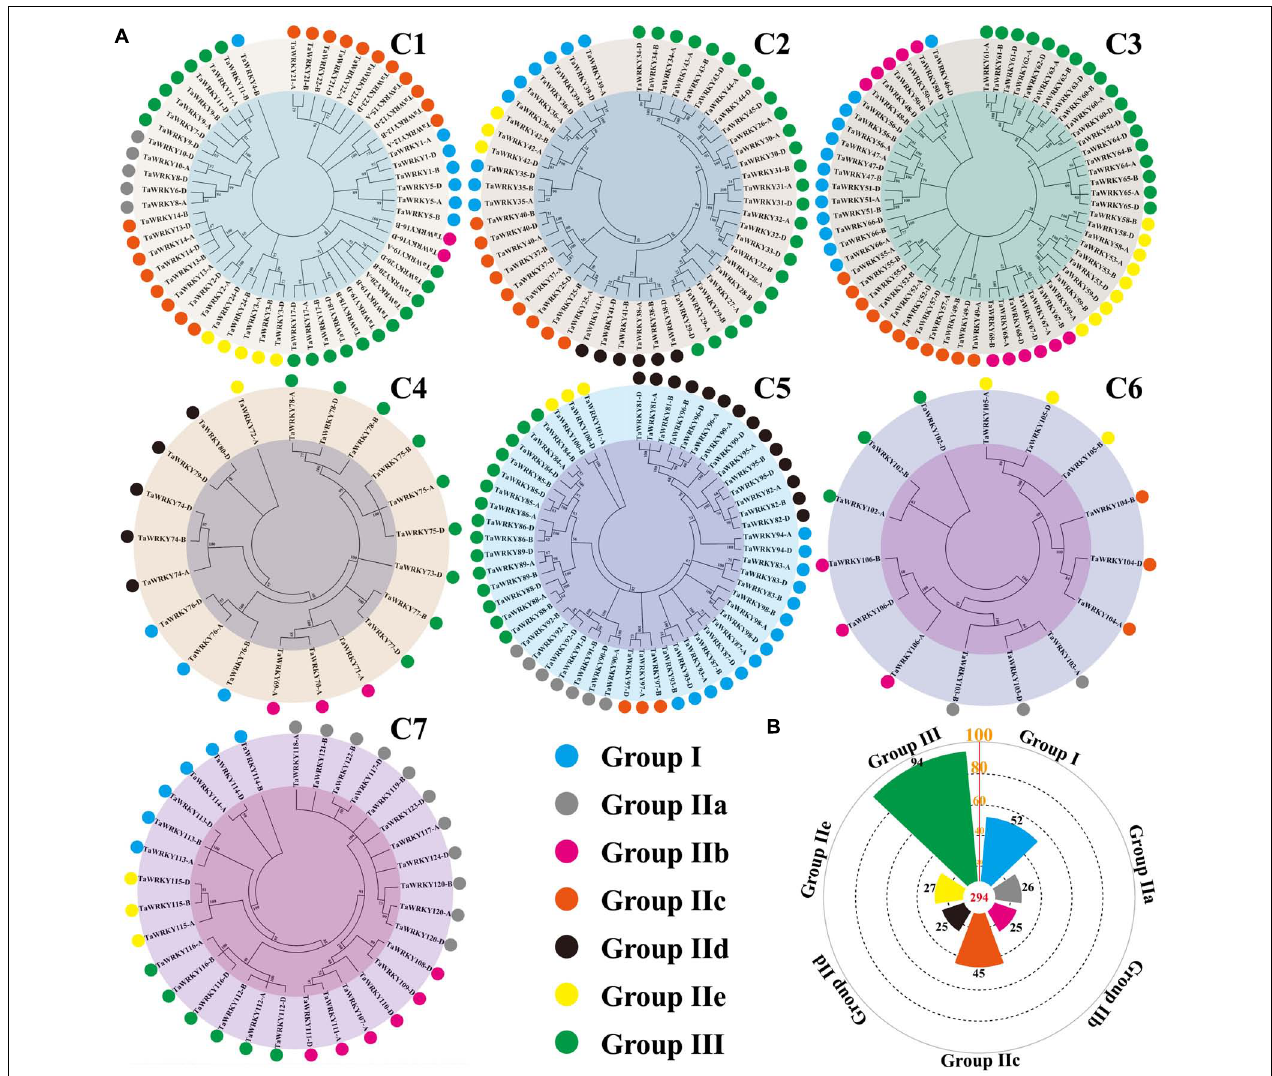
FIGURE 3 | Phylogenetic classification (A) and number of TaWRKY homeologous protein in different groups (B) . Different colors show different WRKY groups. C1–C7 indicate the wheat chromosome